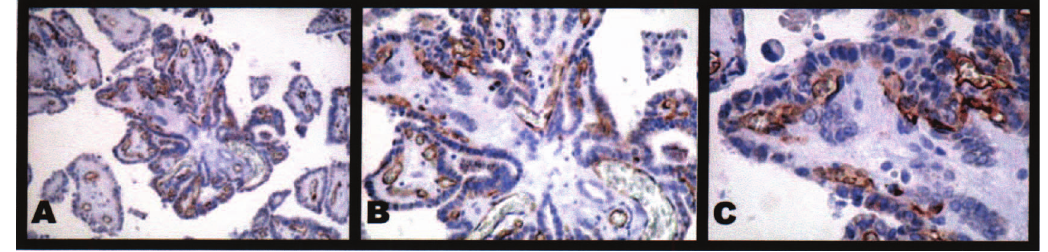
Figure 1 – CD34 staining aspect in papillary thyroid carcinoma. 40x (A), 100x (B) and 400x (C) magnification. The brown-dark represents endothelial cells stained by CD34 antibody in blood vessels of the papillary fibrovascular